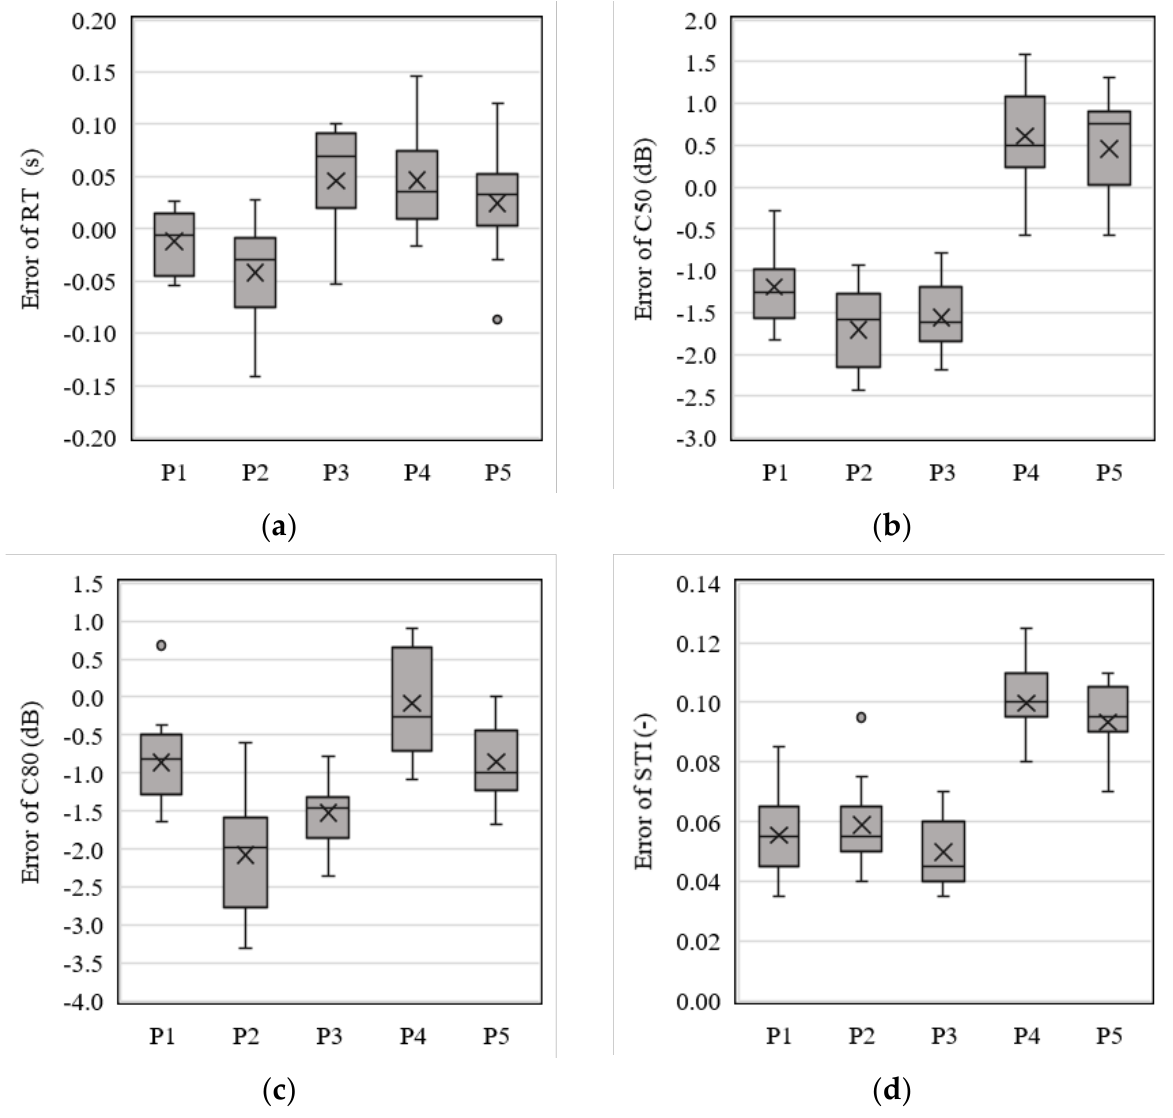
Figure 15. Boxplot of absolute error by each receiver point. ( a ) RT at 500 Hz; ( b ) C50 at 500 Hz; ( c ) C80 at 1000 Hz; ( d ) STI. The JND of the measured and simulated values of the overall data is shown